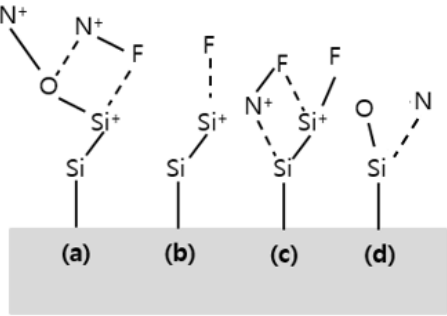
Figure 8. Etching mechanism of the silicon oxide thin film using NF 3 . ( a ) Fluorine ions interpose between Si and O and break the Si-O bond. ( b ) leaves a Si-F bond. ( c ) NF breaks Si-Si bonds by back bonding. ( d ) Releases SiFx and leaves O-N.